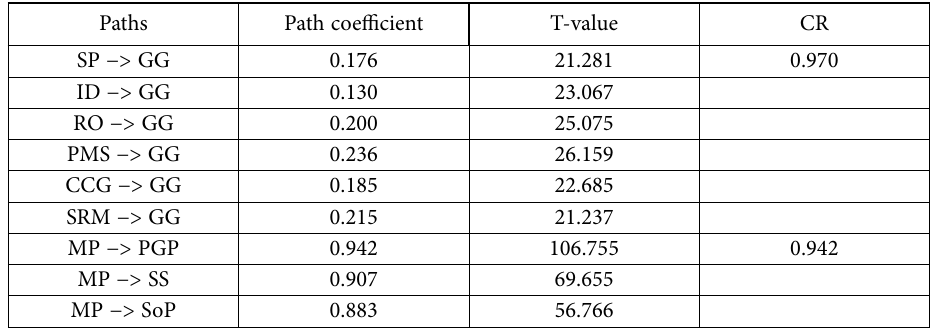
Table 10. Evaluation of structural